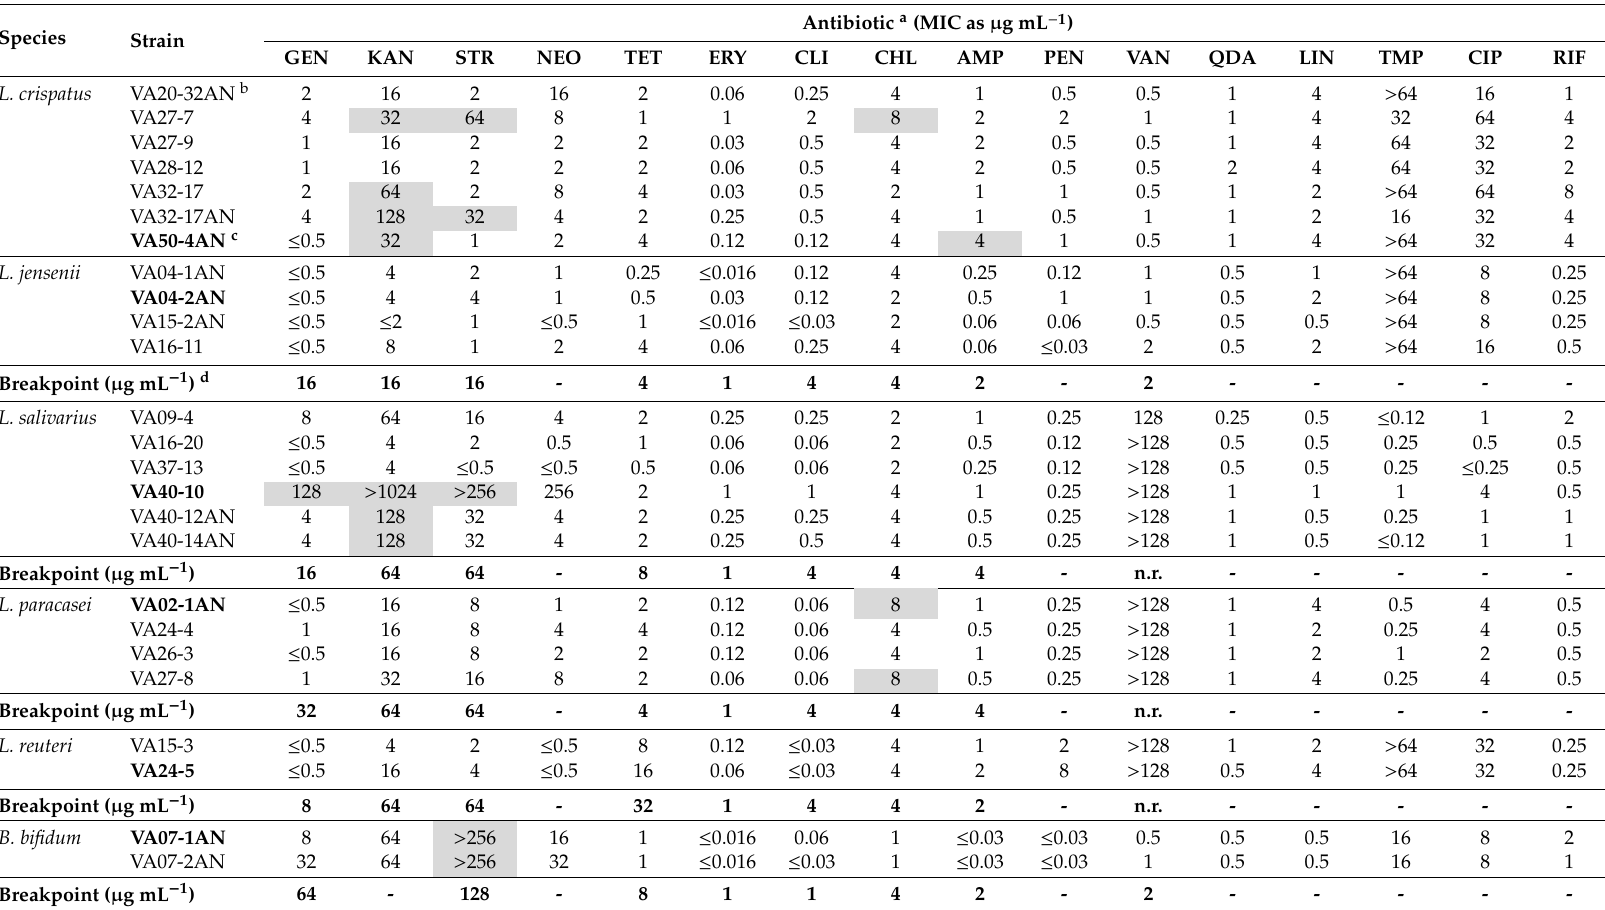
Table 1. Minimum inhibitory concentration (MIC) values of 16 antibiotics to the vaginal LAB species and strains of this study. Species